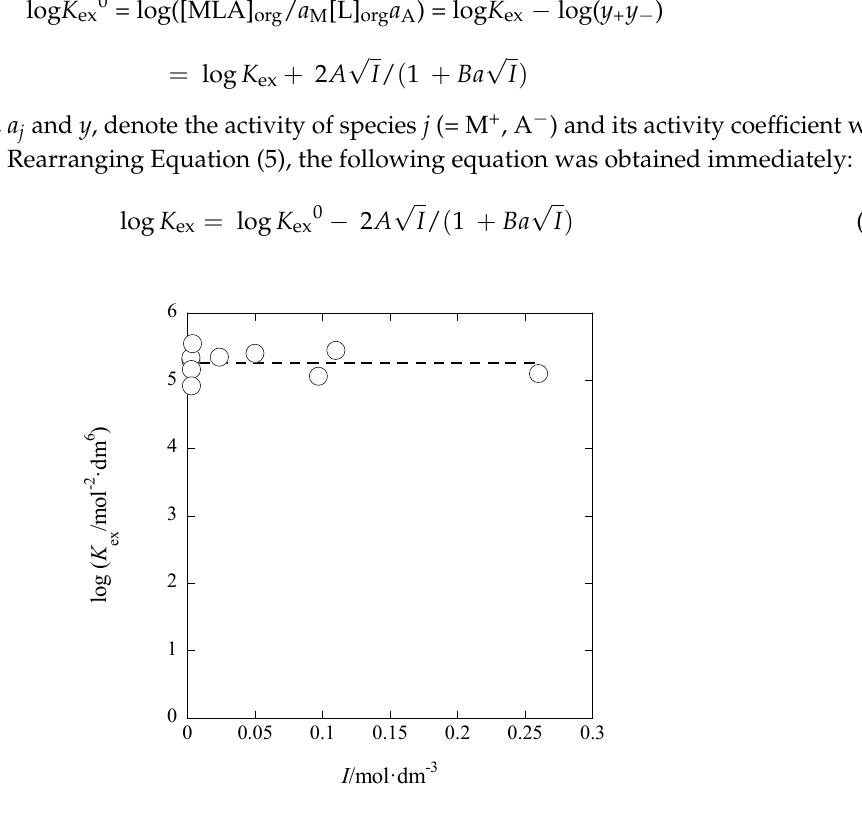
Figure 5. A plot of log K ex vs. I for the AgPic extraction with B18C6 into DCE. See the text for the regression line (broken line). Error bars were added for only the present experimental values in